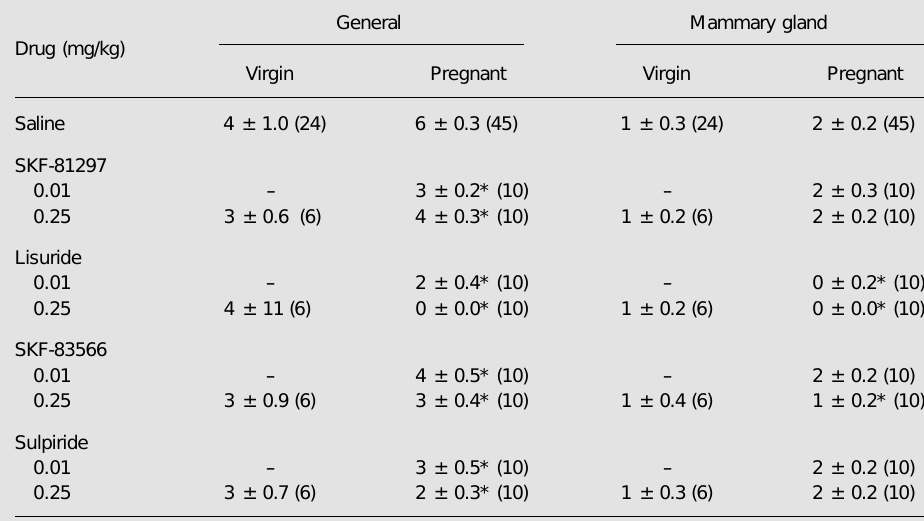
Table 3. Effects of stimulation and blockade of dopamine receptors on frequency of grooming behavior in virgin and pregnant rats.